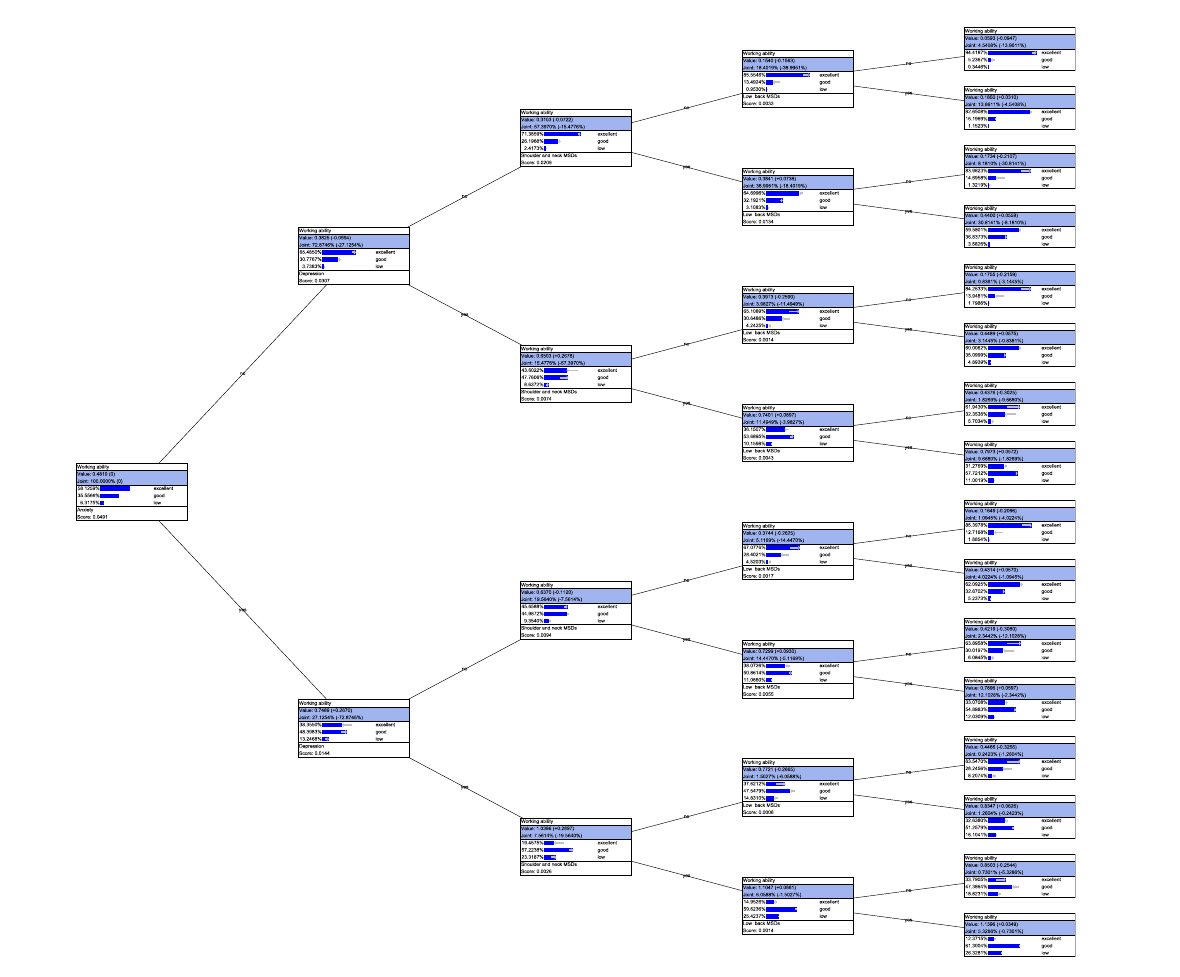
FIGURE3 Bayesian probability interpretation tree model of work ability. In Figure 3 , the arrows in the figure indicate the trends of the probability distribution changes, the joints in the tree are the joint probabilities, and the score is equal to the mutual information MI score.